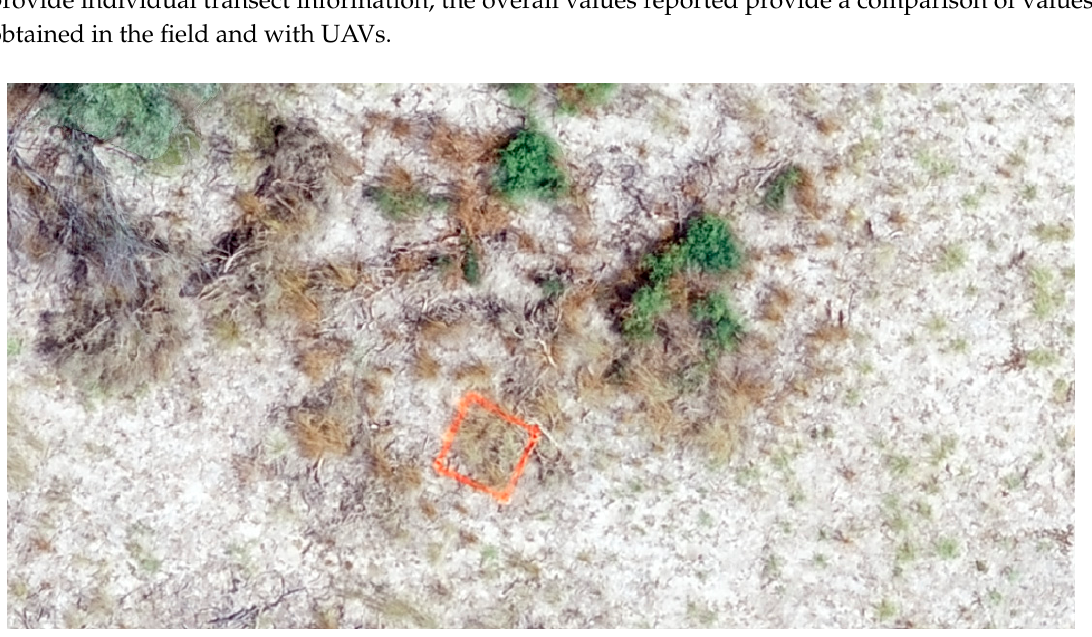
Figure 3. Orange spray-painted quadrat shown from UAV imagery at Duval County Ranch in Duval County, TX, 31 August 2018.